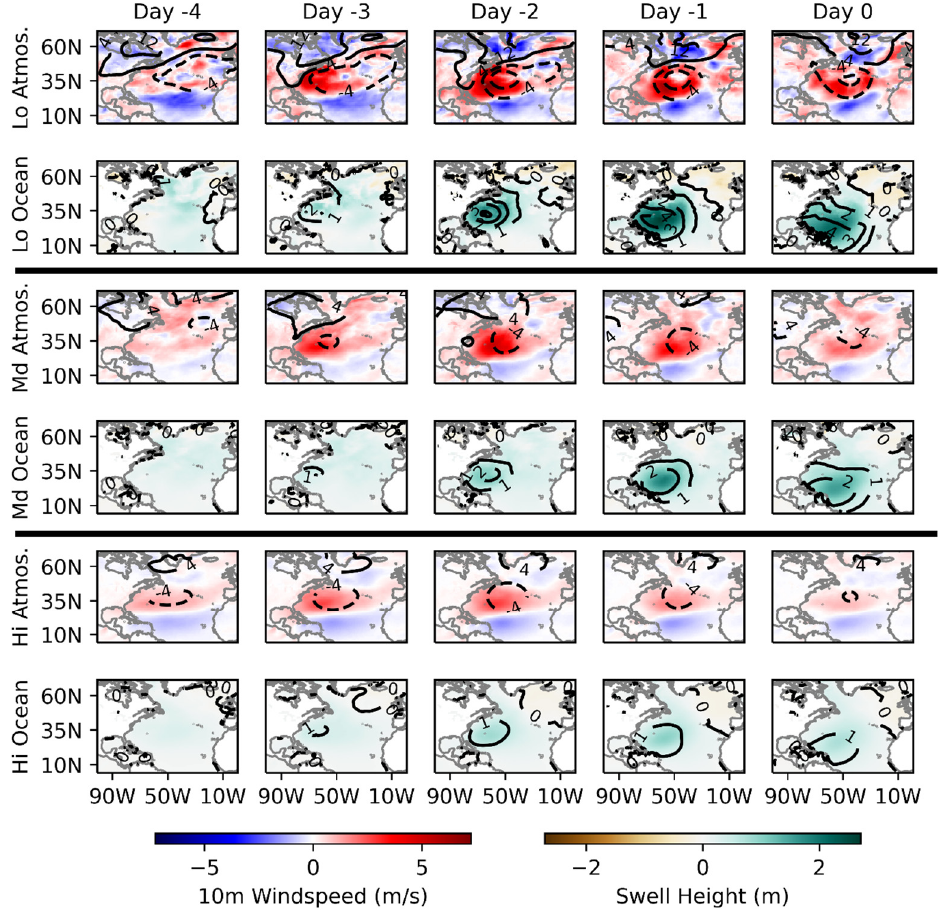
Figure 11. Same as Figure 10 except anomaly composites for low probability north swell events (Lo; rows 1–2; 12 days composited), medium probability north swell events (Md; rows 3–4; 75 days composited), and high probability north swell events (Hi; rows 5–6; 1036 days composited). Probabilities are defined as: Lo < 0.25, 0.25 ≤ Md ≤ 0.75, Hi > 0.75. Day 0 is the day that was classified as belonging to one of the three swell probability groups.